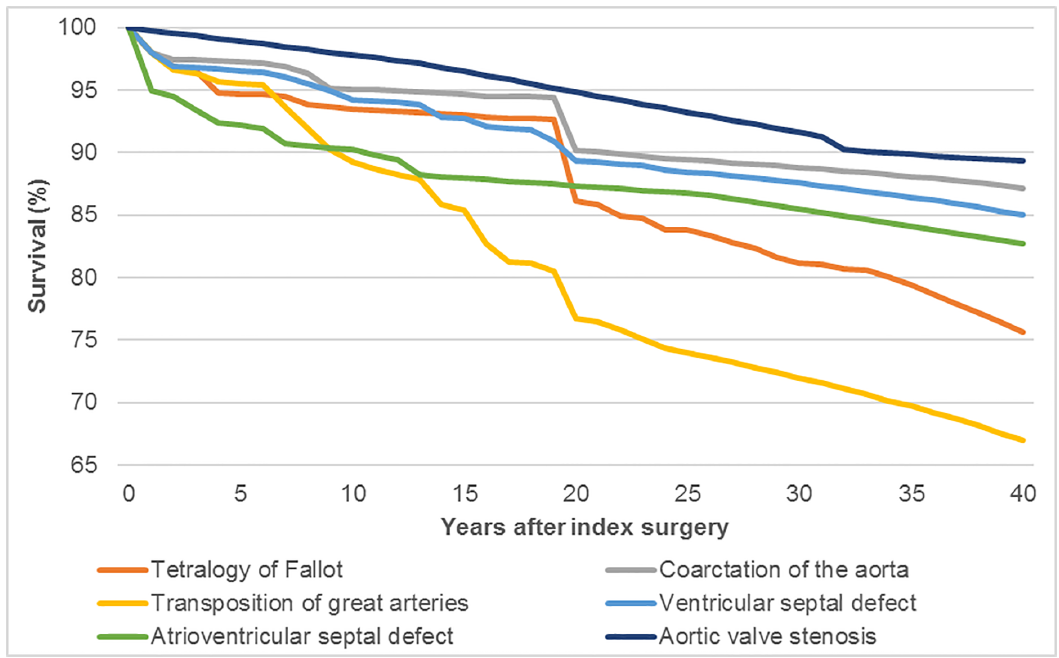
Fig 2. Observed and extrapolated survival. CHD—congenital heart defects, AS—aortic valve stenosis, VSD—ventricular septal defect, AVSD—atrioventricular septal defect, ToF—tetralogy of Fallot, TGA—transposition of great arteries, CoA—coarctation of the